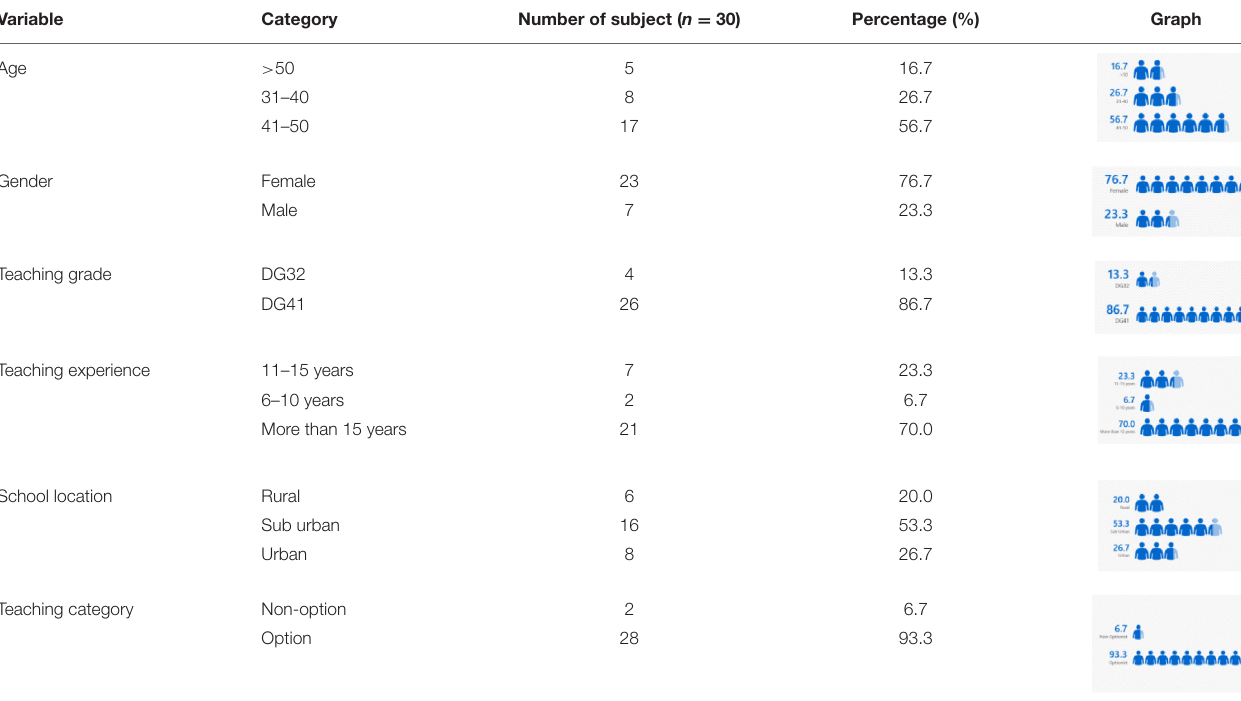
TABLE 1 | Frequency table for demographic